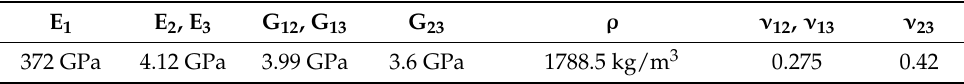
Table 1. Material properties of a lamina in the host laminate.